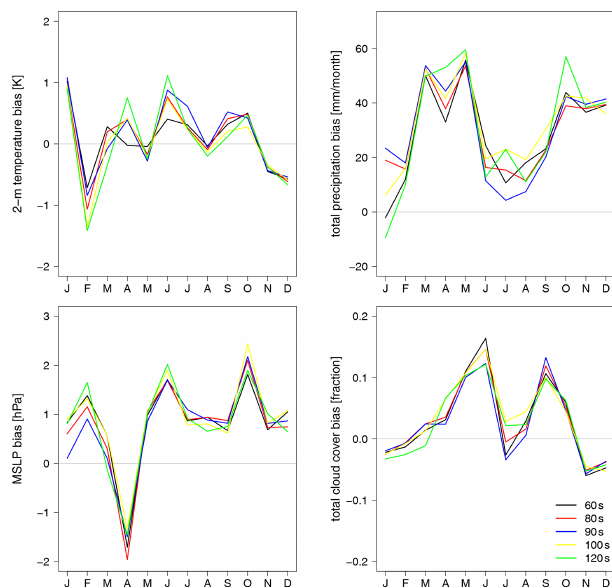
Figure 3. Monthly averaged biases from ICON-CLM simulations with different time steps for 2m temperature, total precipitation, MSLP compared to E-OBS data and total cloud cover compared with CRU time series (TS) data. Data were averaged for the Alps (AL) subregion and for the year